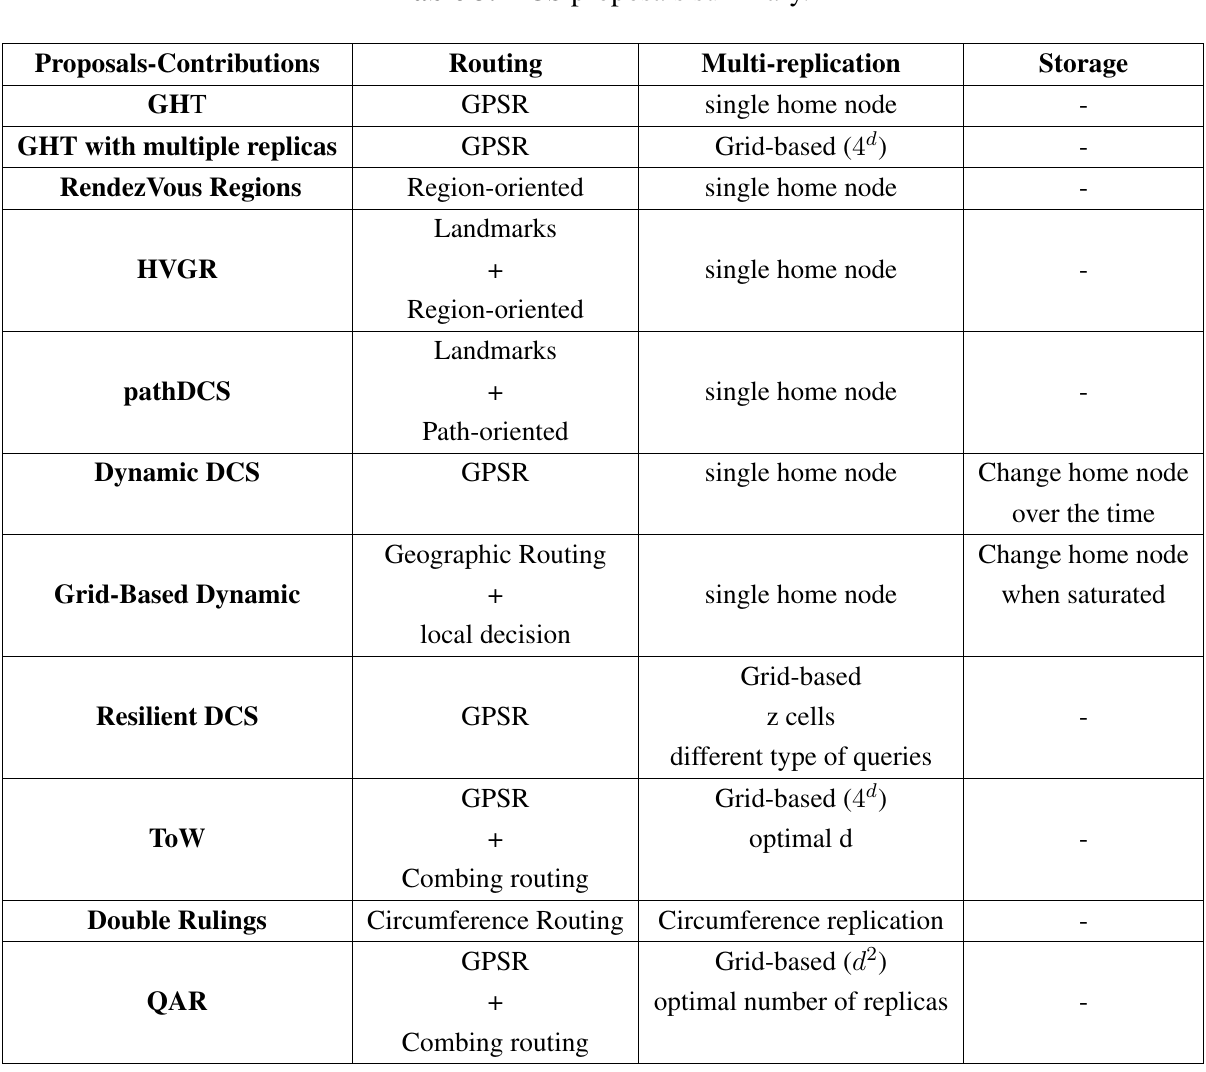
Table 3. DCS proposals